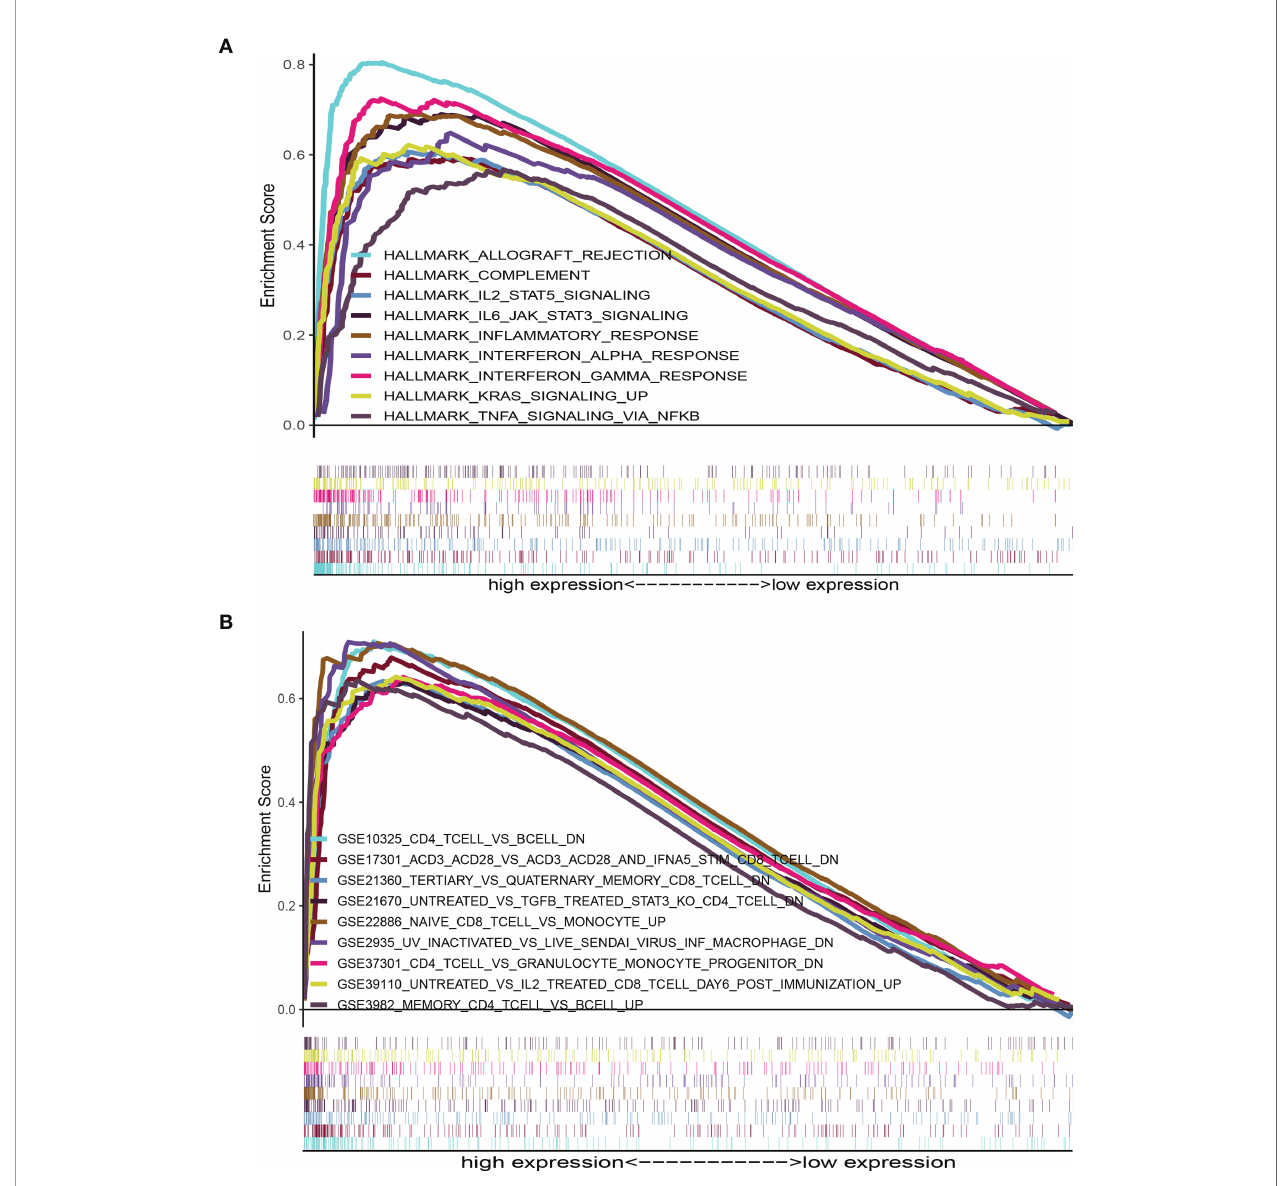
FIGURE 5 | GSEA for HER2+ BC samples with AMPD1 expression. (A) The enriched gene sets in HALLMARK collection by the high AMPD1 expression sample (nominal p < 0.05 and FDR-adjusted q < 0.05). (B) Enriched gene sets in C7 collection, the immunologic gene sets, by samples with high AMPD1 expression (nominal p < 0.05 and FDR-adjusted q <